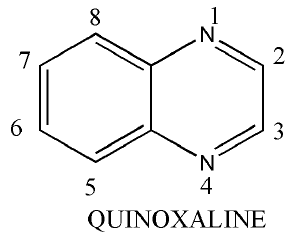
Figure 1. Structure of Quinoxaline.